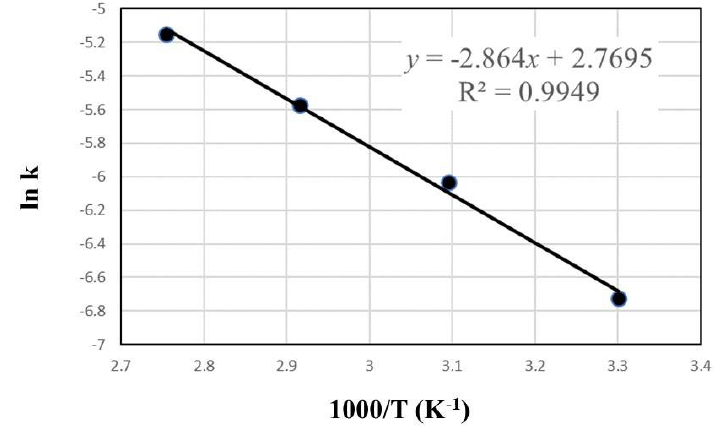
Figure 10. Photos of ground PCBs used in the leaching tests.